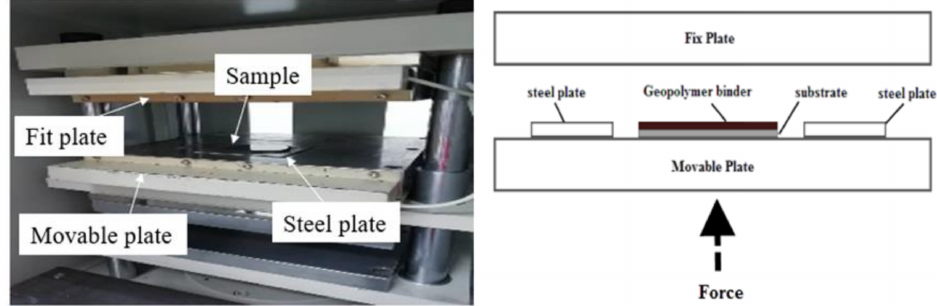
Figure 5. Pre-drying and press process using the hot press machine ( left ) and schematic diagram of the hot press machine ( right